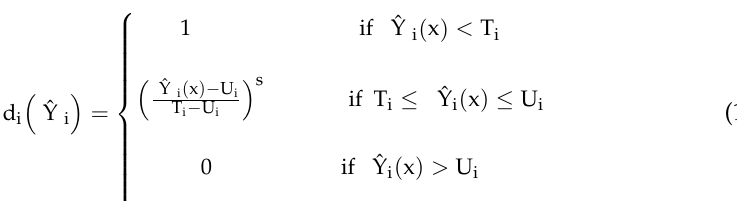
( b ) Figure 20. Response optimization desirability plot ( a ) MoS 2 -loaded CEC and ( b ) h-BN-loaded CEC.